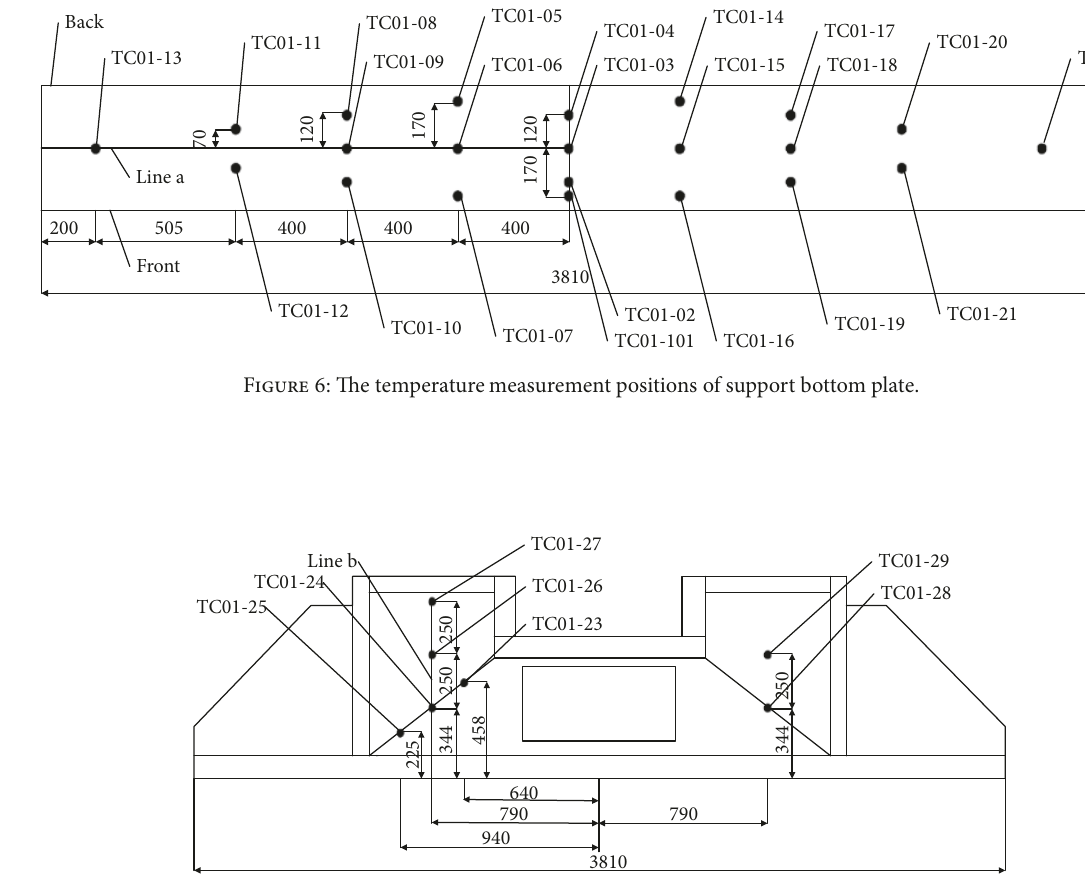
Figure 7: The temperature measuring positions of support front plat.